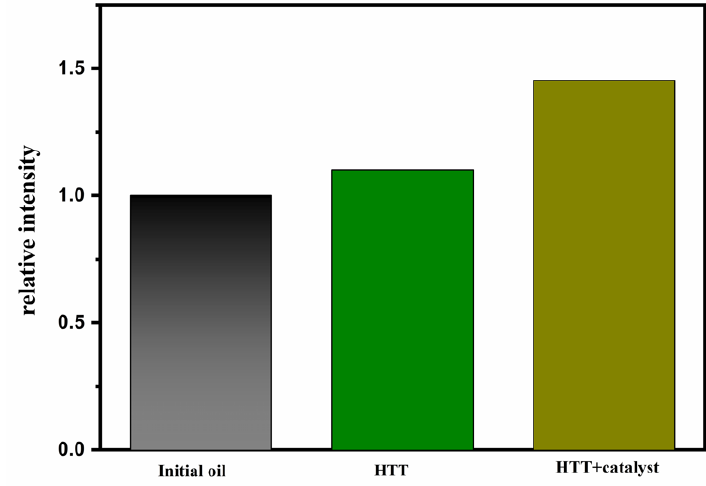
Figure 10. Relative intensities of free radicals.